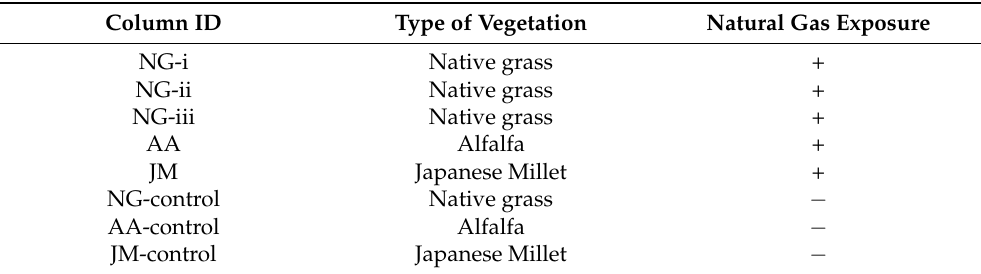
Figure 2. Experimental columns with different types of vegetative covers. Table 2. Vegetation type and gas exposure details of columns.